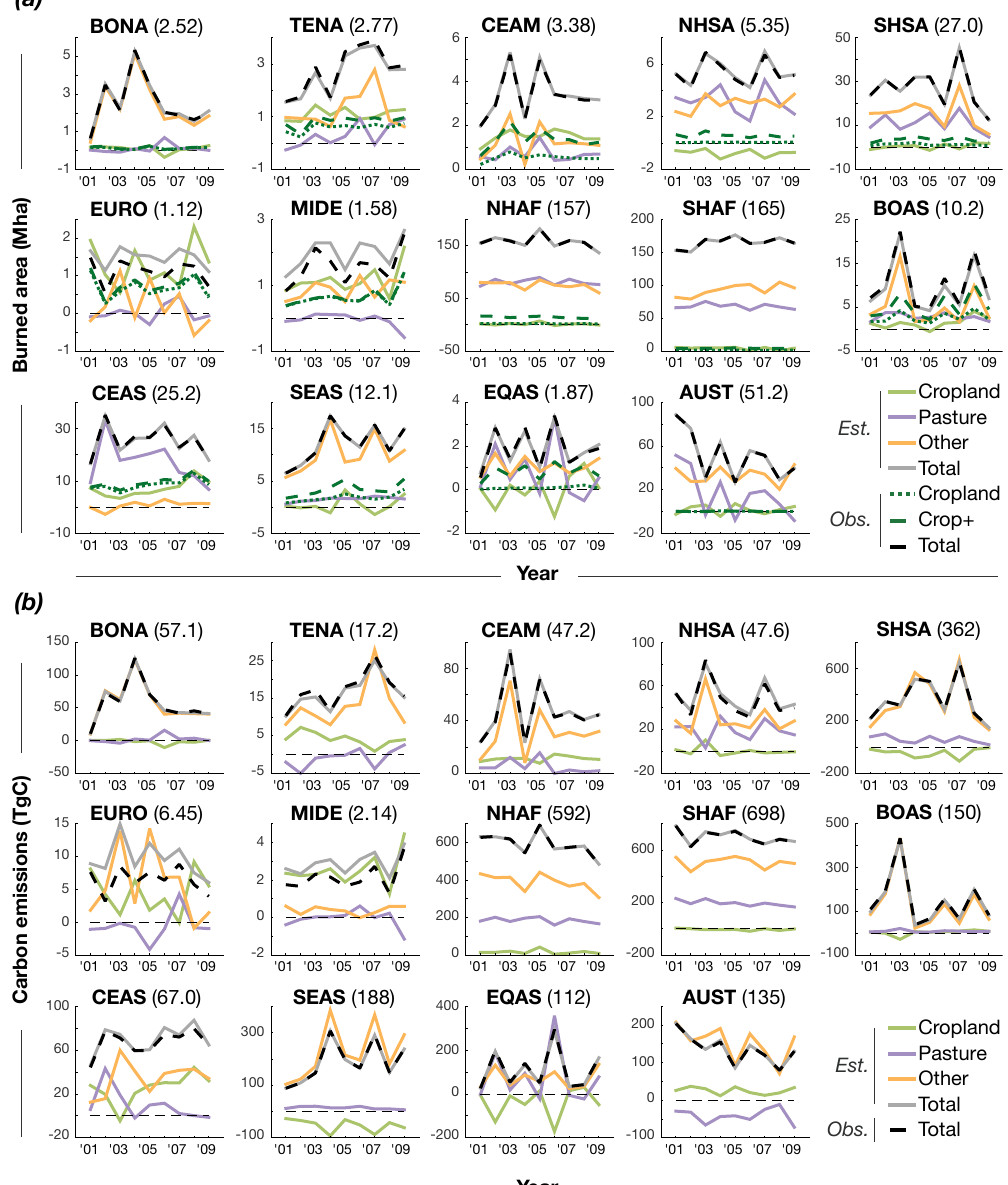
Figure 3. Annual time series of different fire types in each GFED region based on analysis of burned area ( a ; Mha) and C emissions ( b ; TgC). Numbers in parentheses next to region names represent mean annual observed fire there (either burned area or C emissions). “Crop + ”: cropland + cropland–natural mosaic. Corresponds to Fig. S3. Data available in the Supplement.